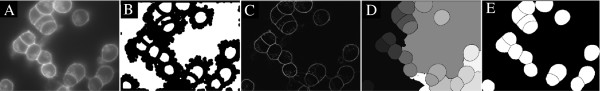
Segmentation of cells in 3D using automatically detected markers in Example 6. A) Raw surface stain, B) automatically detected markers, C) smoothed and ridge enhanced surface stain, D) watershed image, E) detected cells.